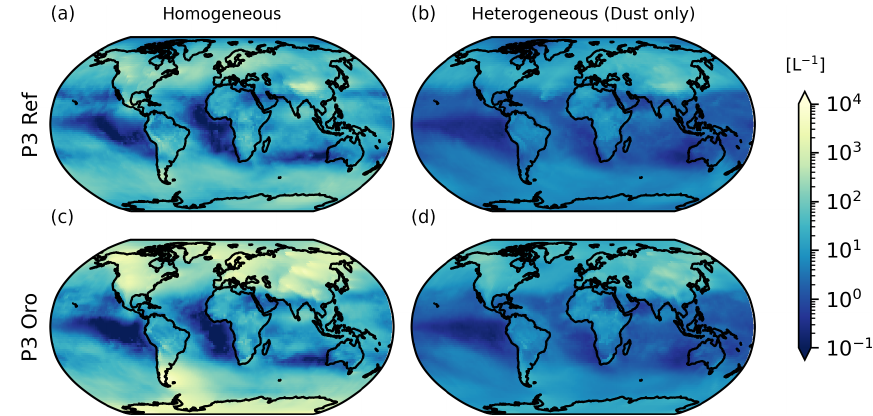
Figure A3. Five-year annual mean spatial distributions of in situ ice number tracers in L − 1 at 200hPa for (a–b) P3 Ref (full D19 set-up as per the main text) without orographic effects and (c–d) P3 Oro with orographic effects active. The first column shows the distribution of the in situ homogeneously nucleated ice number and the second column shows the total in situ heterogeneously nucleated ice number, which includes dust only as these are non-seeding simulations.